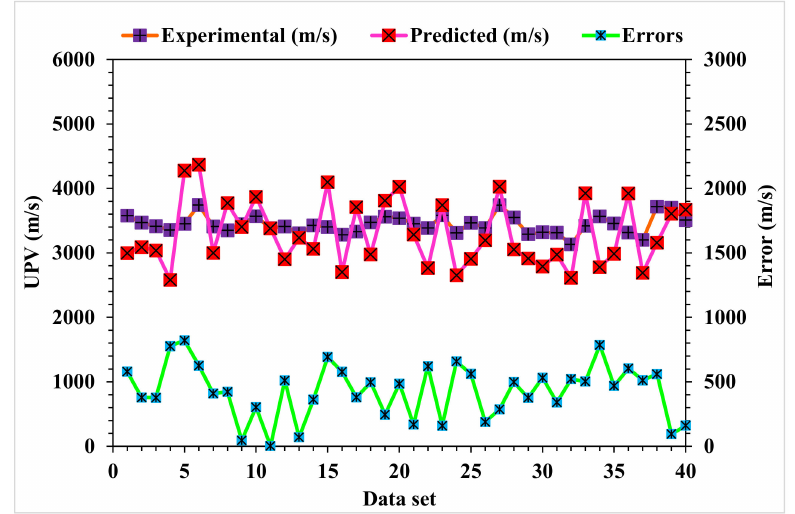
Figure 13. Random Forest model experimental and predicted values with the